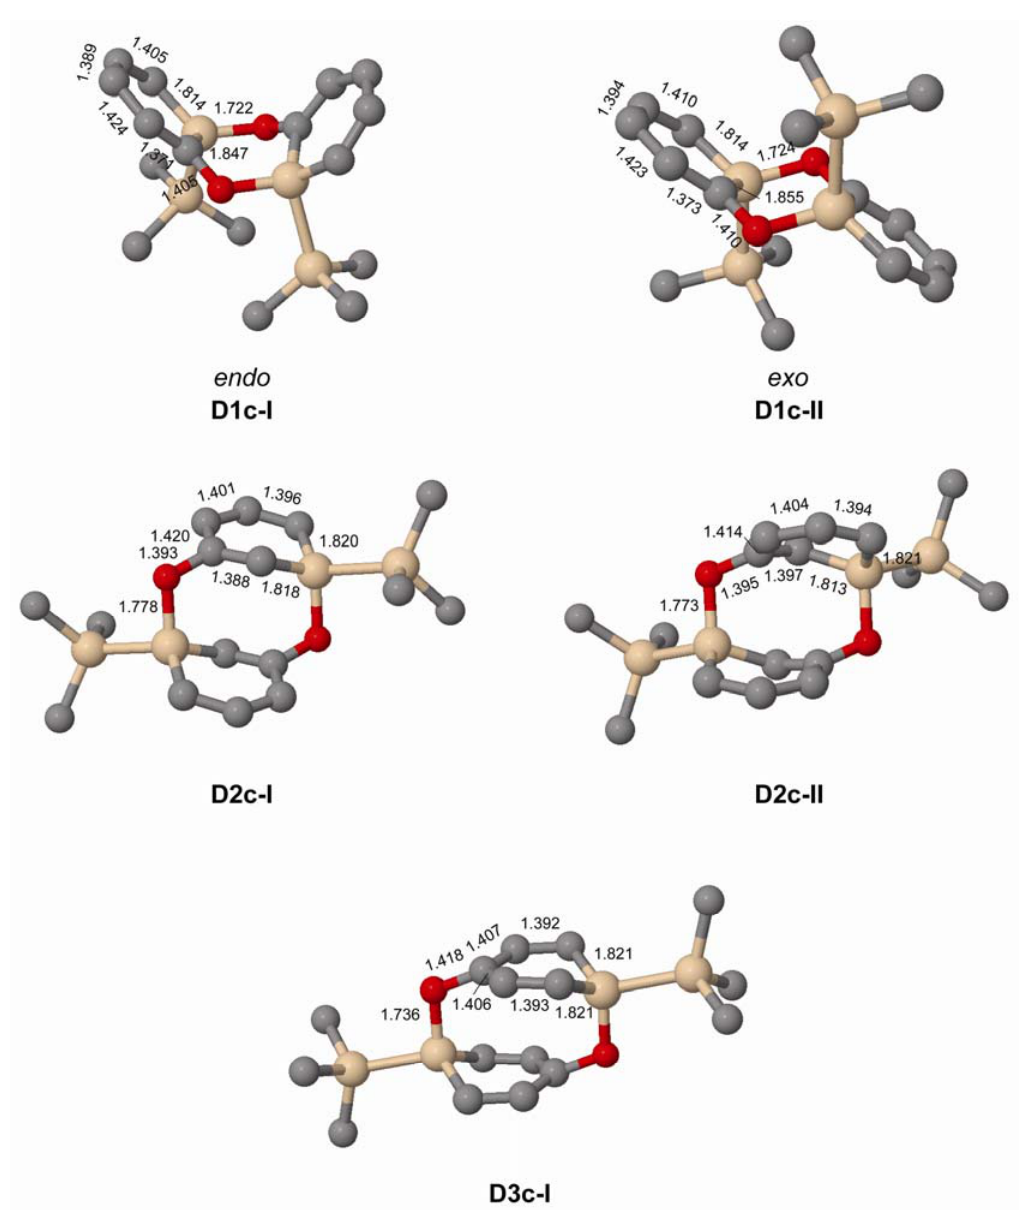
Figure 5. Geometries of doubly Si-O bonded dimers of 1c – 3c (C the M062X/6-31G(d) level. Distances in Å. Hydrogen atoms omitted for